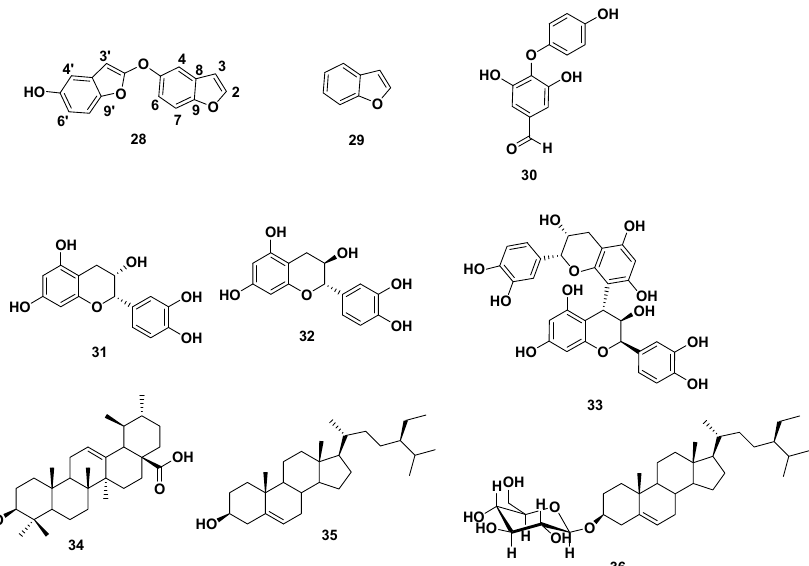
Based on physicochemical as well as chromatographic characters, the spectra obtained from UV, proton ( 1 H), with DEPT-Q NMR, along with the relation to the biography and some authoritative references, the crude extract of V. vinifera seeds provided the new benzofuran dimer ( 28 ) along with eight known compounds (Figure 10).